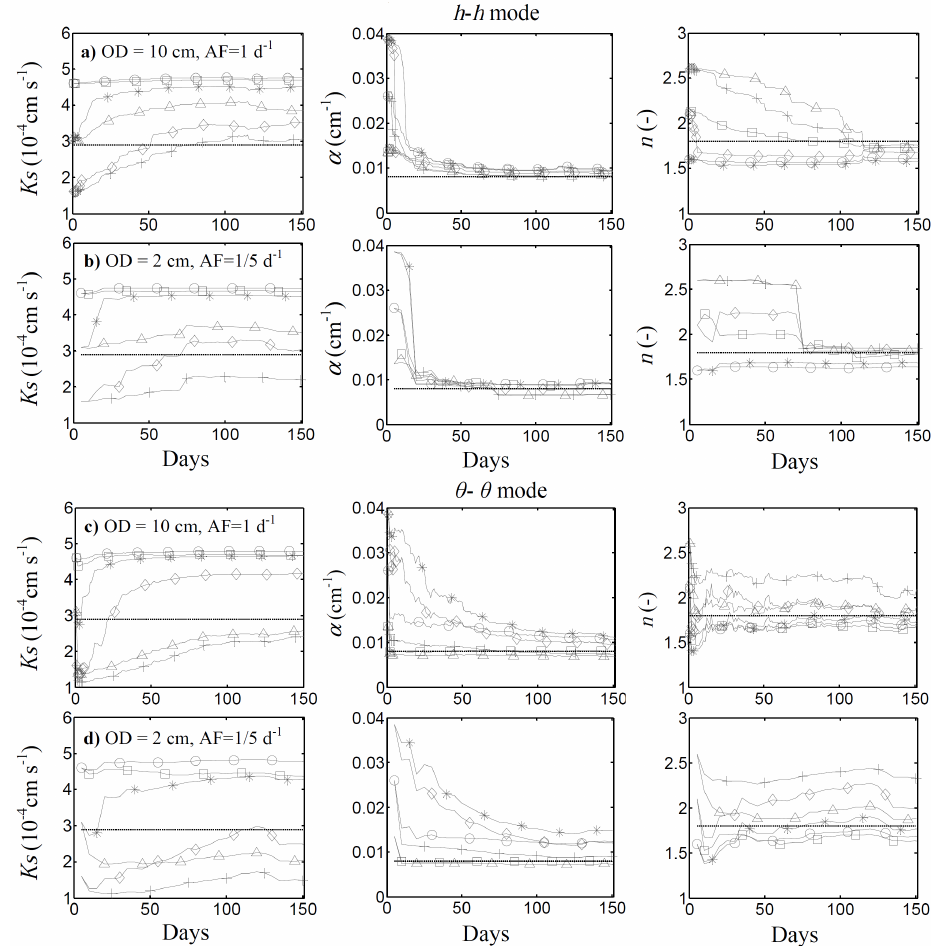
Figure 7. VGM parameters K s , α and n retrieved with the DSUKF algorithm, using the h - h (a–b) and the θ - θ (c–d) retrieval modes, with the following assimilation scenarios: (a, c) OD = 10cm and AF = 1d − 1 ; (b, d) OD = 2cm and AF = 1/5d − 1 . Comparisons account for the six pondered sets of initial parameters: S1( (cid:13) ) , S2( (cid:3) ) , S3( ∗ ) , S4( 1) , S5( + ) and S6( ♦ ) . The dotted line indicates the true value. Table 4. Average RMSE of the state profiles estimated during the last 15 days of simulations with the six sets of initial parameters (S1– S6), considering either one, two or all three uncertain parameters. The results refer to the open loop simulations, the SKF (involving only state retrieving) with OD = 10cm and AF = 1d − 1 , the DSUKF with OD = 10cm and AF = 1d − 1 , and the DSUKF with OD = 2cm and AF = 1/5d − 1 . h - h mode θ - θ